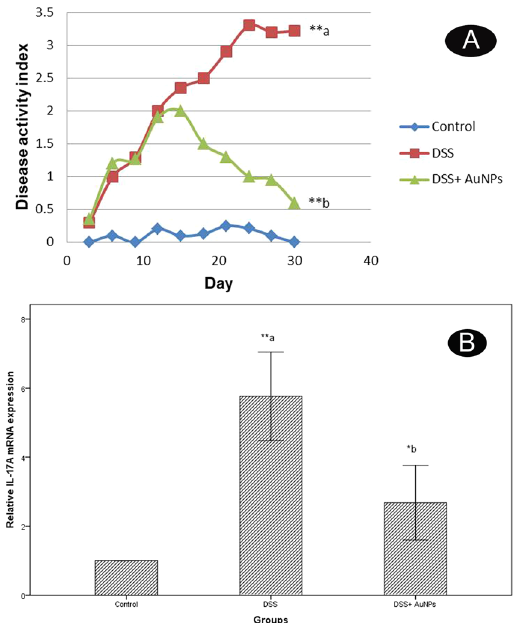
Figure 2. ( A ) Changes in the disease activity index (DAI). a: P compared with control group; b: P compared with DSS group; Asterisks * and ** denote p < 0.05 and p < 0.001 respectively; n = 8. ( B ) Real-time PCR analysis of IL-17A expression levels in the colons of study groups. Values are estimated as a fold-increase compared to IL-17A expression in the calibrator control which is equal to 1. a: P compared with control group; b: P compared with DSS group; Asterisks * and ** denote p < 0.05 and p < 0.001 respectively; n =